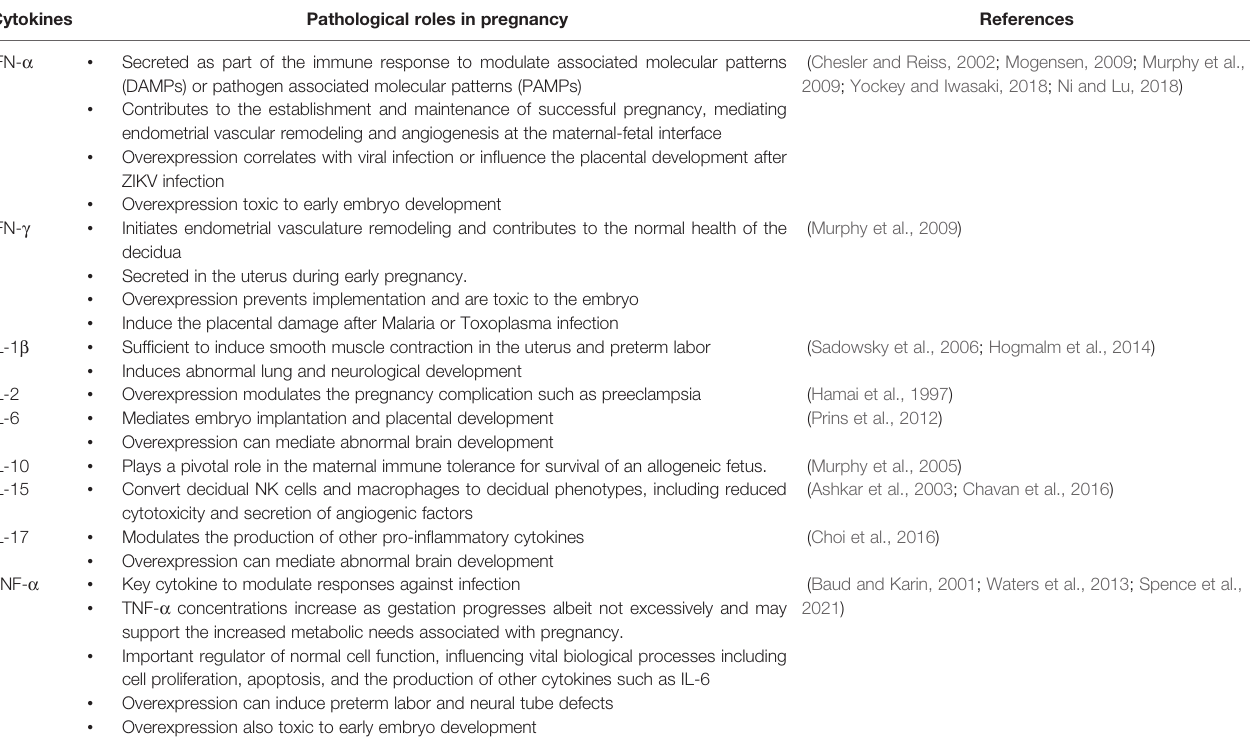
TABLE 2 | Roles of cytokines in human pregnancy complications. Cytokines Pathological roles in